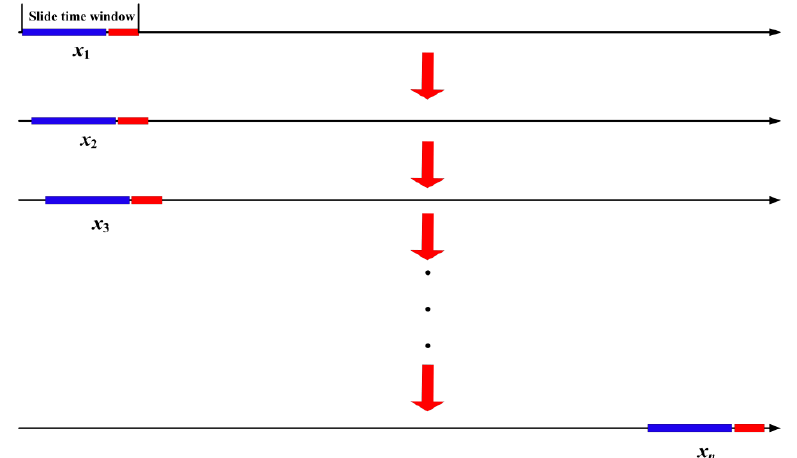
Figure 3. A graphical representation to describe how to generate instances, where the blue bar and red bar in the slide time window indicate the attributes and the corresponding predicting values, respectively.